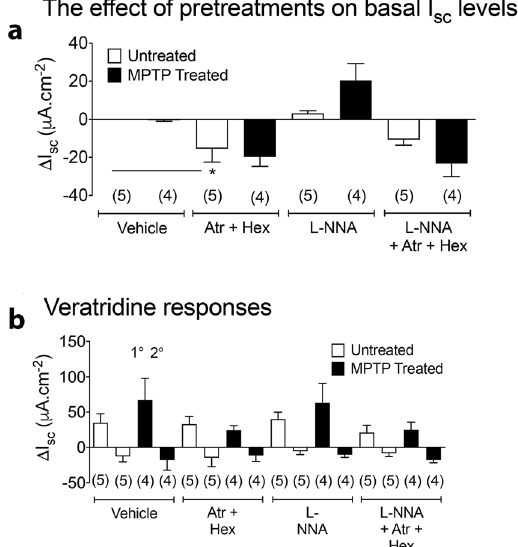
Fig. 3 The effect of cholinergic and nitrergic antagonists. The effect of cholinergic and nitrergic antagonists alone ( a ) and MPTP-treated marmosets. Tissues were treated with either atropine plus hexamethonium (Atr + Hex) alone, L-NNA alone or Atr + Hex +